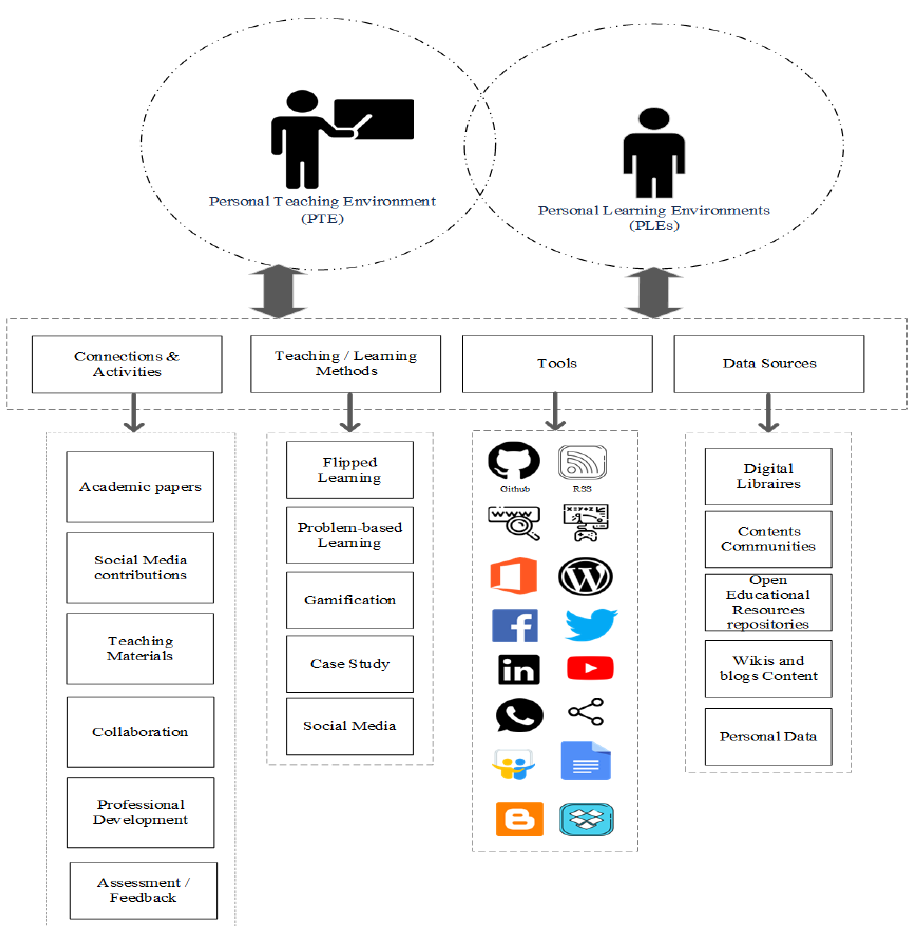
Figure 3. Personal Teaching Environment framework structure.